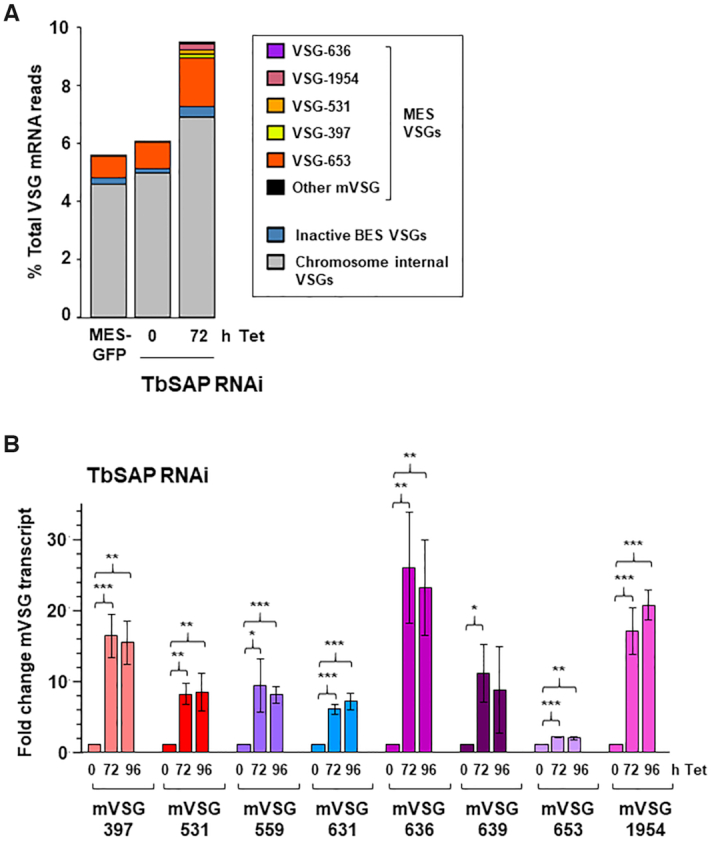
Knockdown of TbSAP results in significant upregulation of metacyclic VSGs in bloodstream form T. brucei. (A) Relative abundance of VSG transcripts following RNAi against TbSAP for 72 h. Only transcripts other than VSG221 (VSG-2), present in the active BES1 are shown. The MES with mVSG-653 is the site of integration of the reporter construct. High levels of MES VSG-653 expression are due to the ectopic rDNA promoter which has been introduced in the construct. Abundance is shown as a percentage of the total VSG transcript reads. (B) Depletion of TbSAP leads to significant up-regulation of all eight MES VSGs. RT-qPCR was performed using RNA isolated from cells where TbSAP RNAi had been induced with tetracycline (Tet) for the time indicated in hours (h). Values were normalised against actin and shown as fold-change relative to the uninduced sample. Values plotted are the mean of three independent experiments with the standard deviation indicated with error bars. Statistical significance for upregulation was determined using Student's t-test (*P< 0.05, **P< 0.01, ***P< 0.001).